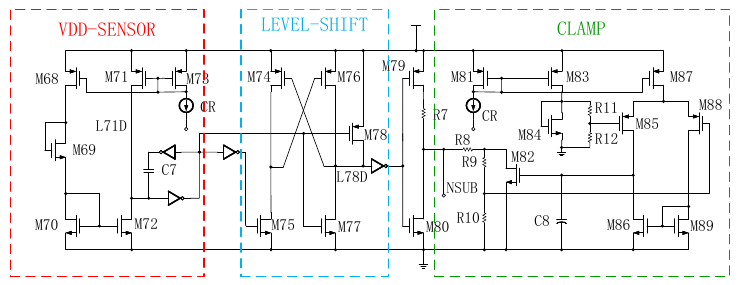
Figure 9. Threshold simulation results for N-P MOS. ( a ) Monte Carlo simulation results for the threshold voltage of the N-P MOS when VDD=0.7V and V SB = 0 V . ( b ) Simulation results of the ( R 9 + R 10 ) at different process corners. variation of threshold voltage with R 12 R 10 ( R 11 + R 12 )